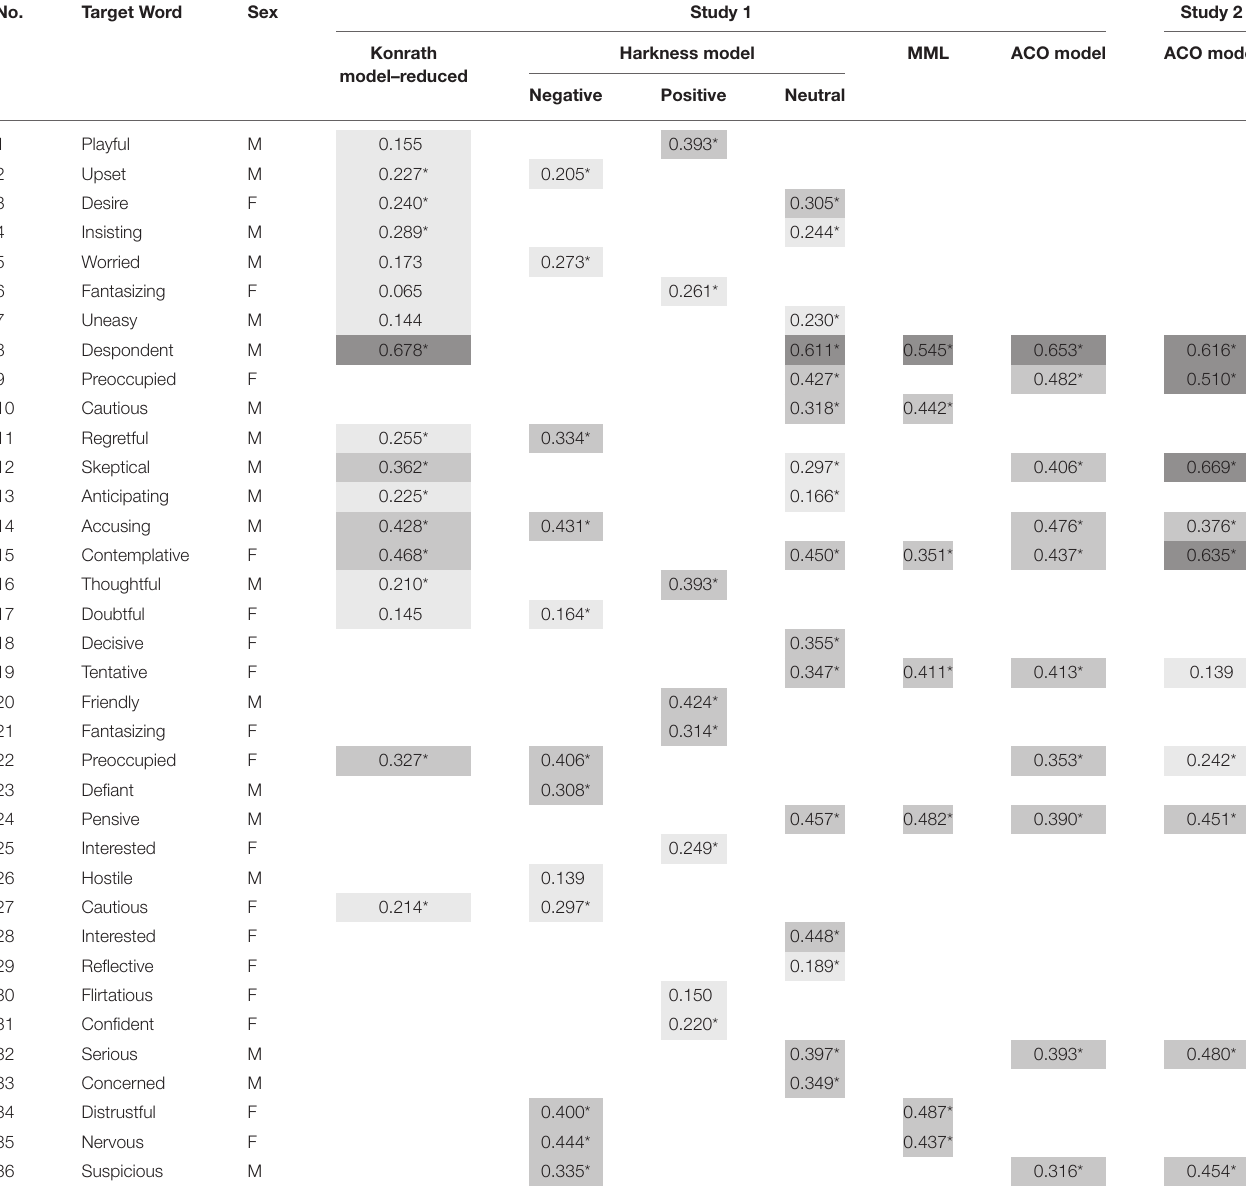
TABLE 6 | Study 1 and 2: confirmatory factor analysis fully standardized loadings ( β ) for all short-form and subscale solutions. No.